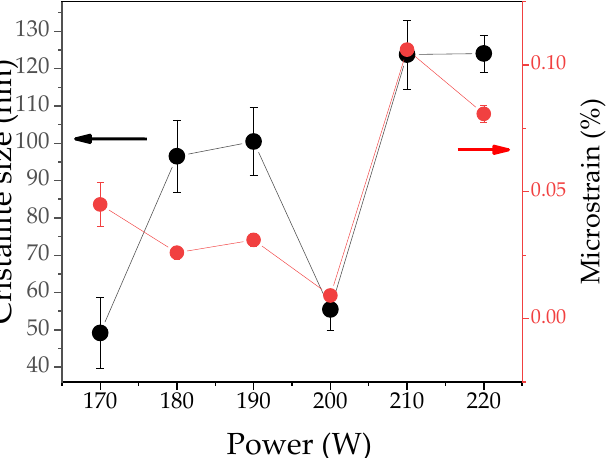
Figure 3. Crystallite size and microstrain, calculated from the Williamson – Hall method [26].